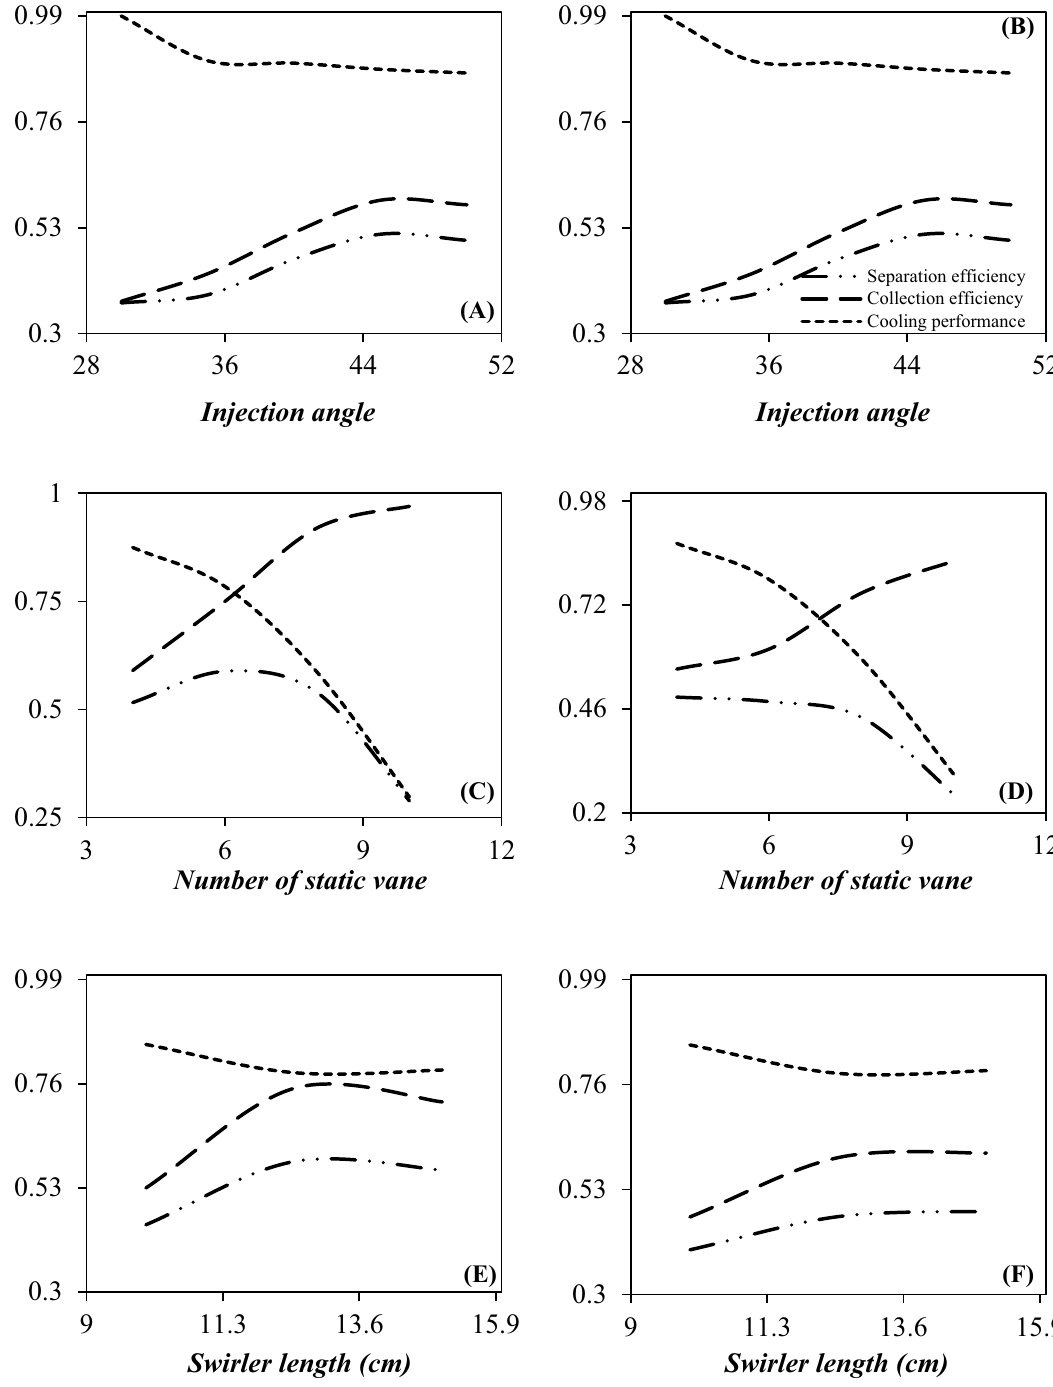
Figure 6. The influence of injection angle ( A, B ), number of static vane ( C, D ) and swirler length ( E, F ) on the cooling performance, collection efficiency and separation efficiency of water ( A, C and E ) and HC ( B, D and F ) droplets with the diameter of 2